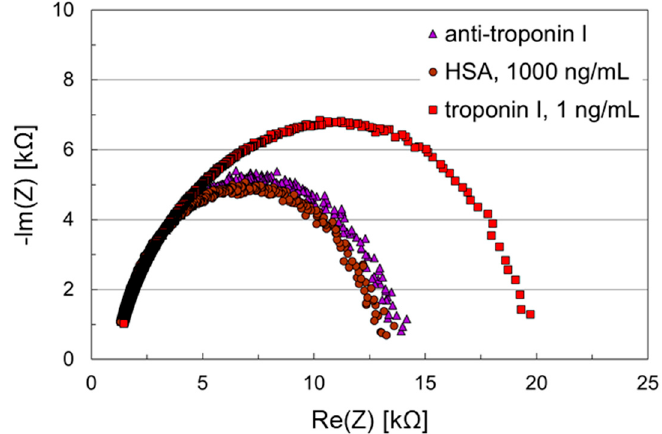
Figure 7. Nyquist plots of an impedance biosensor chip with DNA-based SAM for troponin I detection. The working electrode was coated with anti-troponin I, which was immobilized on a SAM consisting of thiolated DNA and 1,4-benzenedithiol. The counter electrode was coated with 1,4-benzenedithiol. Samples containing HSA, 1000 ng/mL, and troponin I, 1 ng/mL, were applied subsequently to the biosensor chip.